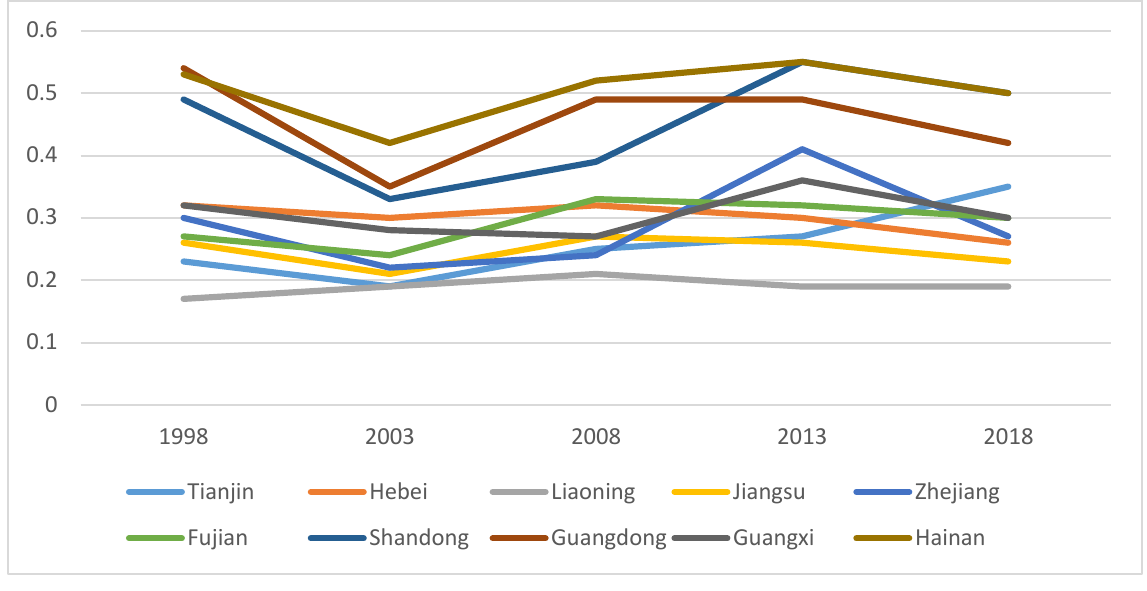
Figure 1. Productivity in Eastern Provinces during 1998 – 2018.